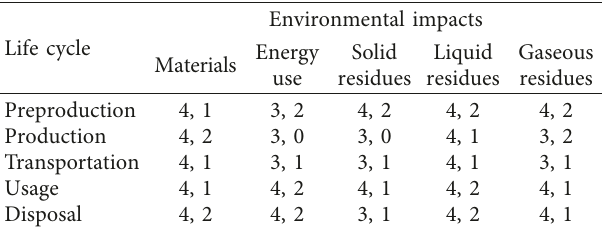
Table 6: 5 × 5 matrix assessment for cloud rail and